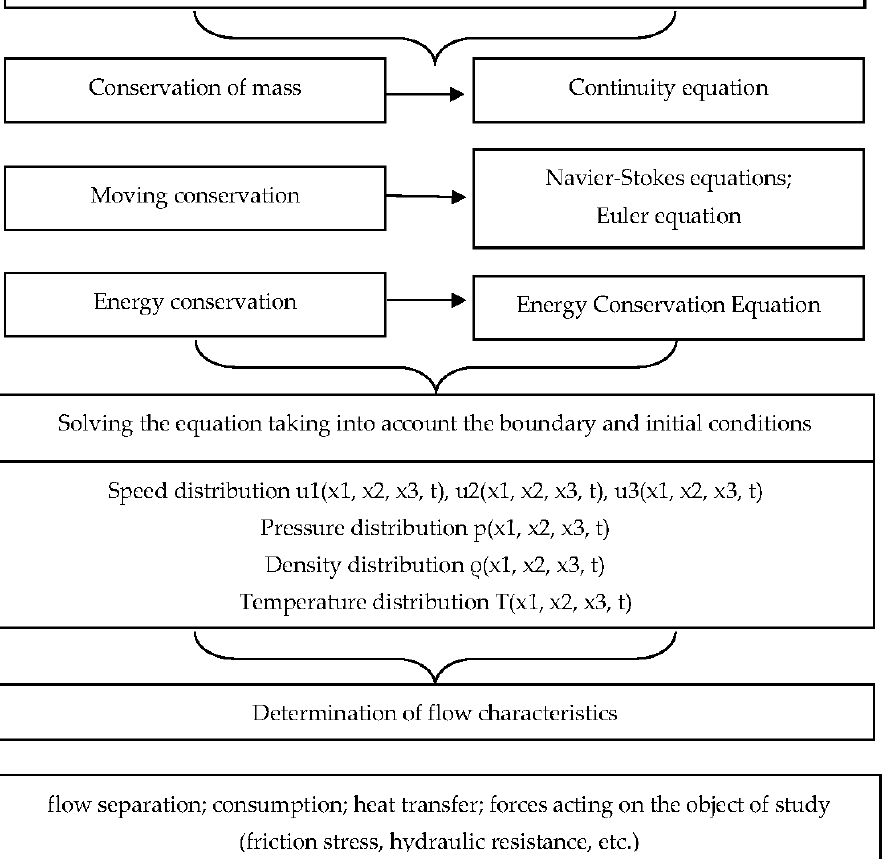
Figure 7. Software block scheme of the computational fluid dynamics method.